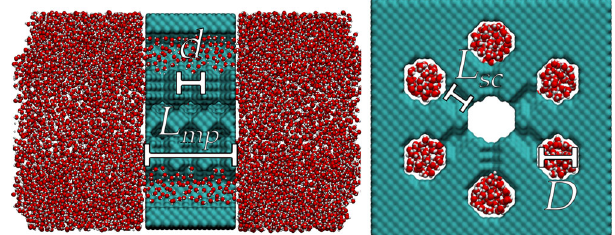
Fig. 1 Snapshot of the system. The system consists of two reservoirs of liquid water separated by a nanoporous slab with the main pores connecting them. Front and lateral views highlight the presence of orthogonal secondary channels connecting the main pores. The diameter of the main pores, D , is 1.54 nm. The secondary channels diameter, d , is 0.77 nm. The length of the main pores, L mp , is 3.15 nm. The length of the secondary channels, L sc , is varied in this study; in the illustrated example, L = 1 nm. This fi gure was realized using Visual Molecular Dynamics sc (VMD) 50 , a molecular dynamics visualization